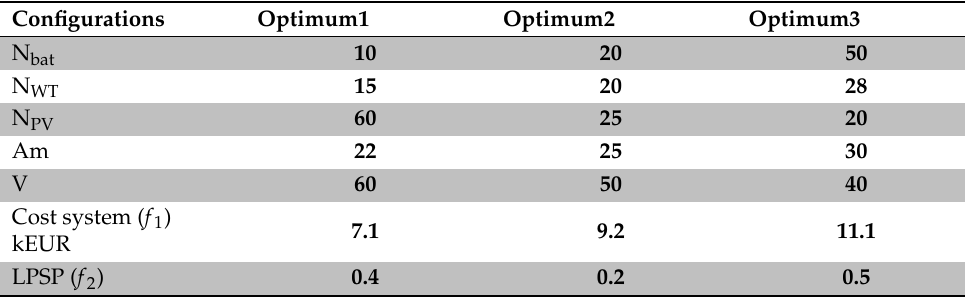
Table 4. The characteristics of the selected